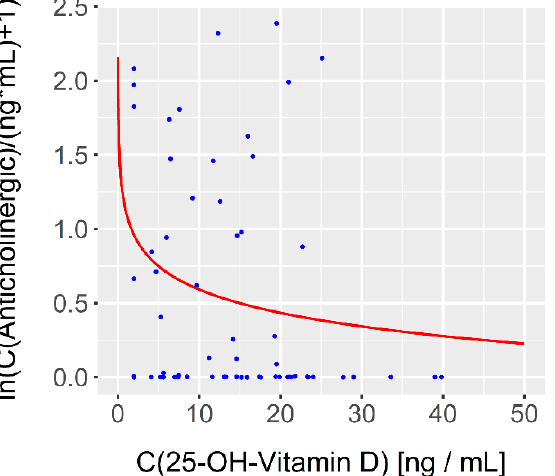
Figure 3. The relationship between 25-OH vitamin D-levels and exposure to anticholinergic antipsychotics. Scatter plot of the association between 25-OH-vitamin-concentration ( x -axis) and antipsychotic drug concentrations adjusted for anticholinergic potency ( y -axis). Curve fitting revealed a best fit for a log-transformation of both the dependent and independent variable.